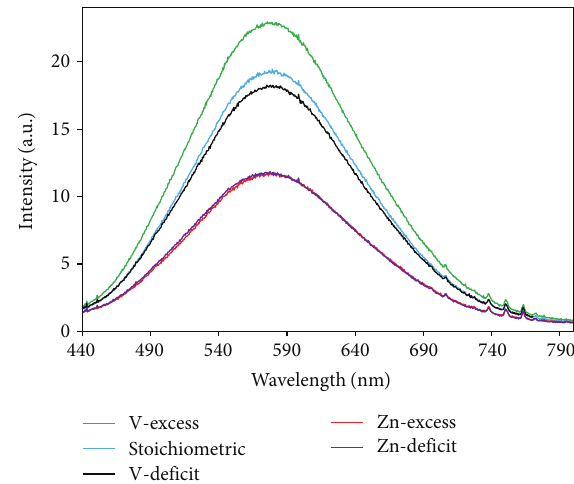
Figure 3: Boric acid flux dependent PL emission spectra of Zn 3 V 2 O 8 phosphor. Figure 4: Effects of V and Zn stoichoimetry on the PL emission intensity of Zn 3 V 2 O 8 phosphor.